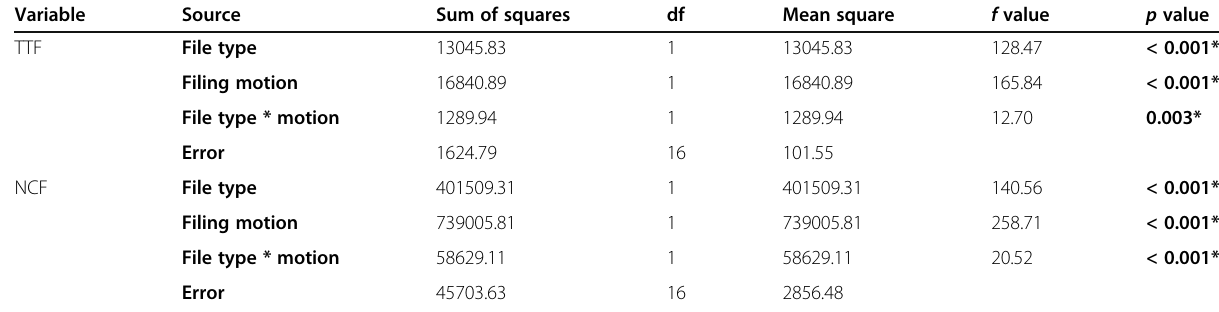
Table 3 Two-way ANOVA test results